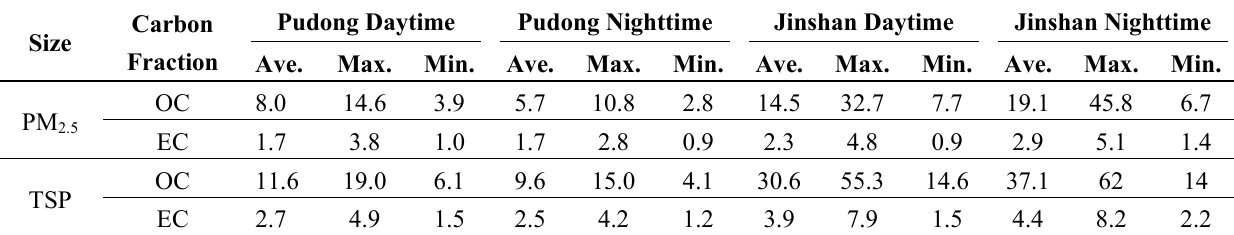
Table 1. The average concentrations of OC, EC for PM 2.5 and TSP at Pudong and Jinshan ( μ g·m − 3